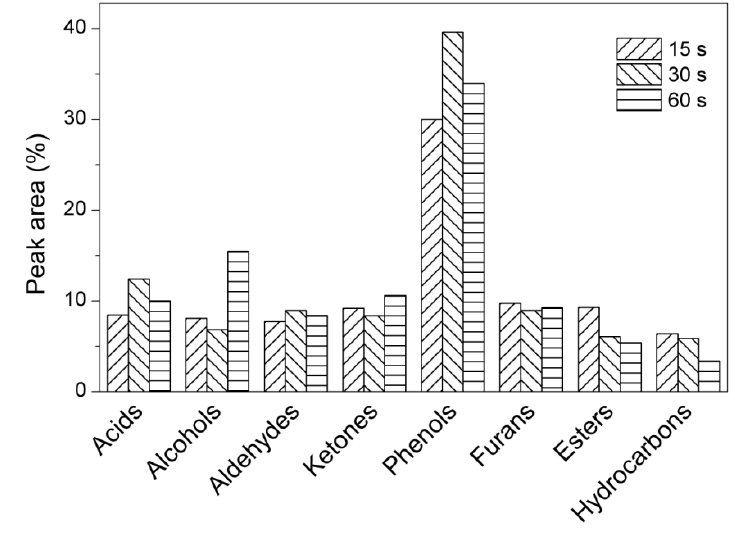
Figure 5. The effect of pyrolysis times from 15 to 60 s at 450 °C on the product distributions of corn stover EHL pyrolysis.